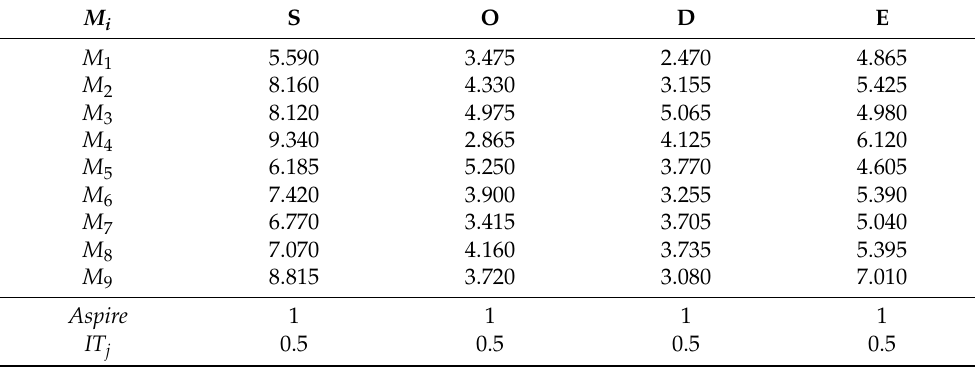
Table 2. The assessment matrix X and the indifference threshold IT j .